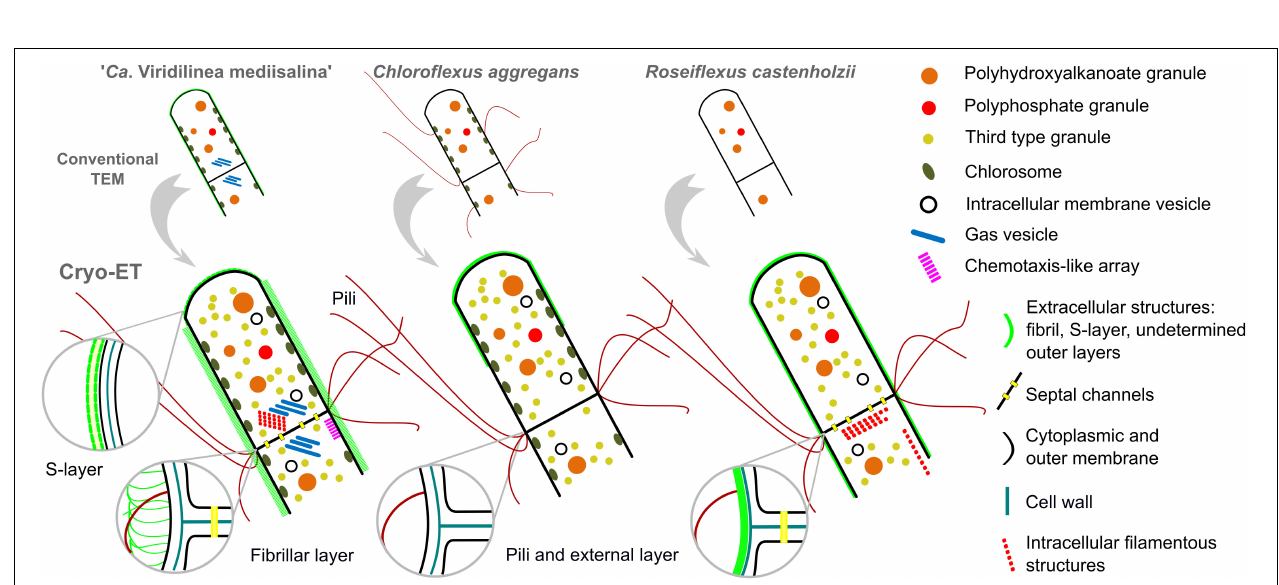
FIGURE 6 | A new view on the cellular ultrastructural organization of Chloroflexales bacteria.